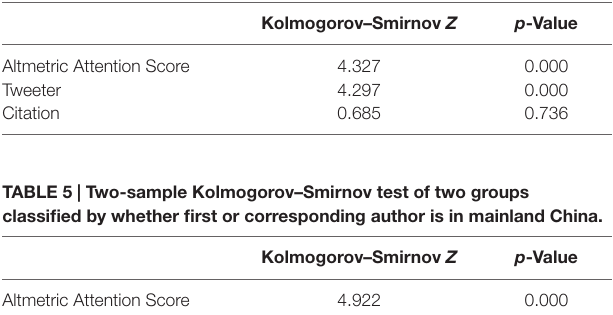
Table 4 | Two-sample Kolmogorov–smirnov test of groups classified by whether all authors are in mainland china.